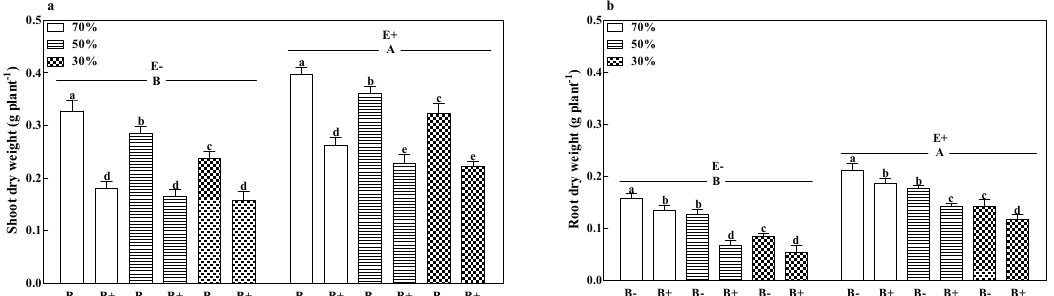
Figure 3. Shoot dry weight ( a ) and root dry weight ( b ) of perennial ryegrass infected with (E+) or without (E − ) fungal endophyte and inoculated (B+) or noninoculated (B − ) with pathogen at 70%, 50%, and 30% soil water regimes at harvest. Mean ± SEM of four replicates are shown. Bars topped by the same lowercase letter indicate no significant difference between soil water regimes and pathogen within fungal endophyte treatments at p ≤ 0.05 by Tukey’s HSD test. Bars topped by the same uppercase letter indicate no significant difference associated with fungal endophyte at p ≤ 0.05 by Tukey’s HSD test.